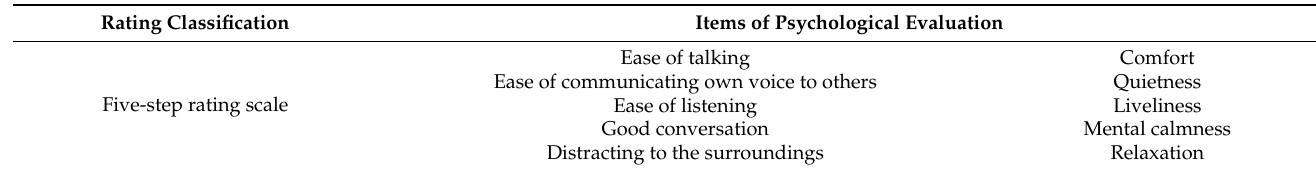
Table 2. The 10 psychological evaluation items used in the experiment.